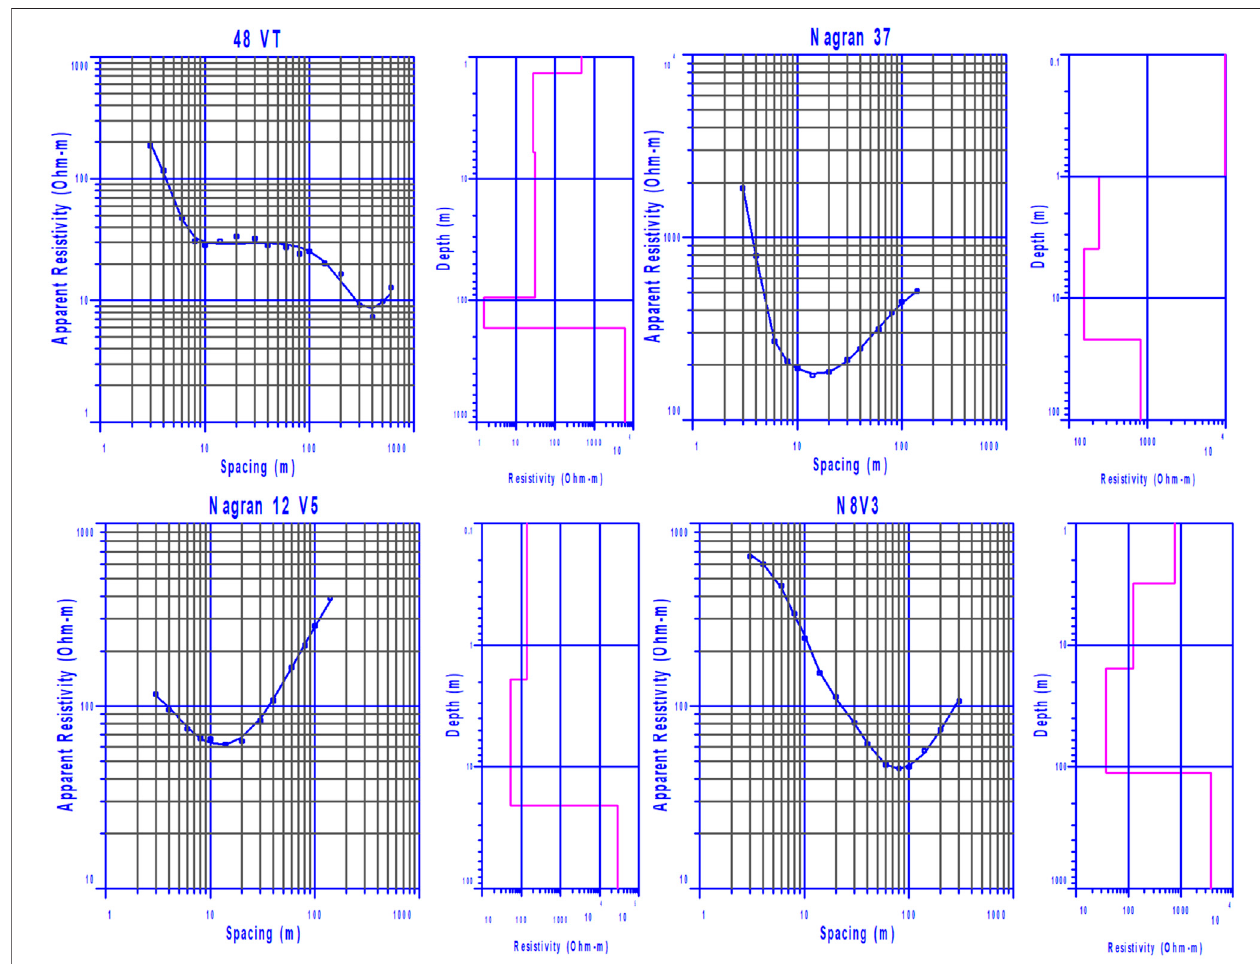
0.03 cm/yr for Period II, whereas Period III shows a highly negative trend, calculated at − 0.67 ± 0.09